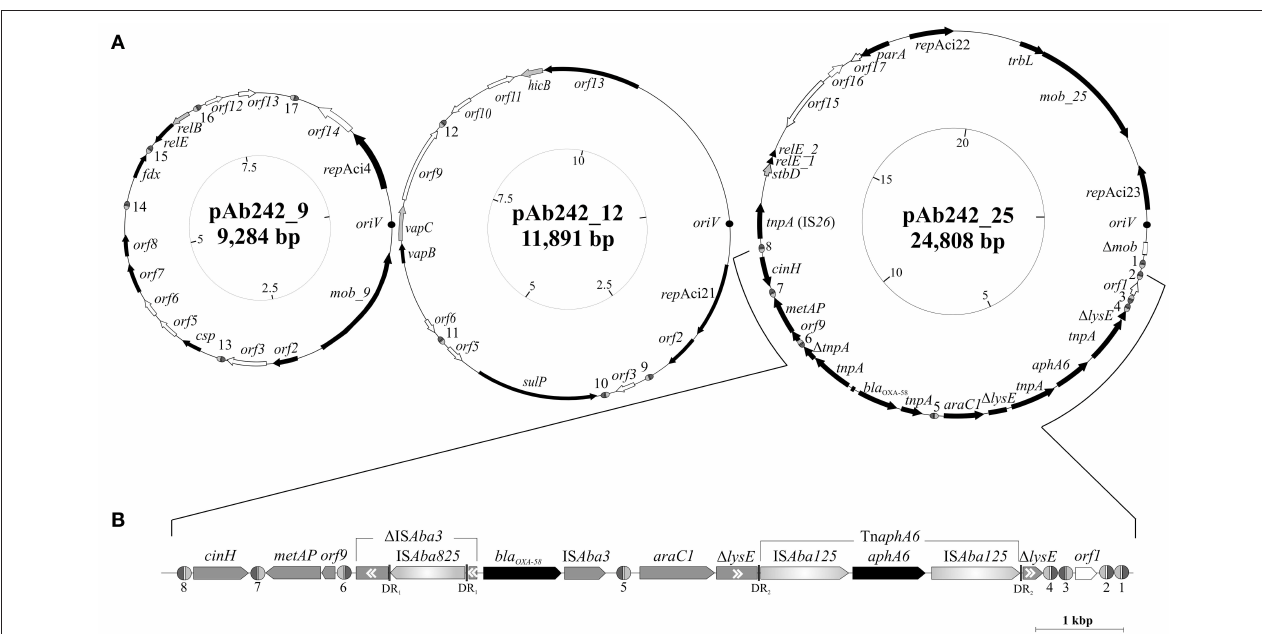
FIGURE 2 | Organization and gene content of A. baumannii Ab242 plasmids. (A) From left to right: inferred schemes of Ab242 plasmids pAb242_9 (KY984045), pAb242_12 (KY984046), and pAb242_25 (KY984047). The ORFs and their corresponding orientations are denoted by arrows. Closed arrows correspond to genes with described functions, whereas open arrows relate to unknown functions. Disrupted and incomplete genes are indicated with a “ 1 ” symbol preceding the gene denomination. The dark circles denote the predicted oriV regions, whose starting bases were arbitrarily set to 1 in the clockwise scale in each case (innermost circles) that also indicates the corresponding lengths in kbp. The different XerC/D-like binding sites identified in this work are highlighthed as ovals (not drawn to scale), with the XerC and XerD recognition regions depicted as dark gray and light gray semi-ovals, respectively, separated by the corresponding cr. Note that not all sites located in a given plasmid show the same polarity. The sequences of the different XerC/D sites are shown in Table 2 . For more details see also Table S3. (B) Expanded view of the antimicrobial resistance structure bearing bla OXA - 58 and aphA6 antimicrobial resistance genes and its close bordering regions. The orientation of each gene is indicated, with the two resistance genes denoted in black. Genes interrupted by IS are indicated in gray boxes with a “ 1 ” symbol, with the double internal arrowheads indicating the original direction of transcription. Thus, 1 IS Aba3 located immediately upstream of bla OXA - 58 denotes the remnants of an original IS Aba3 copy disrupted by an IS Aba825 insertion. In turn, the two 1 lysE fragments bordering the Tn aphA6 composite transposon denote the 5 ′ and 3 ′ remnants, respectively, of the original lysE gene. DR 1 and DR 2 denote the direct duplications generated by the indicated mobile elements at the corresponding target insertion sites (see Table S4 for